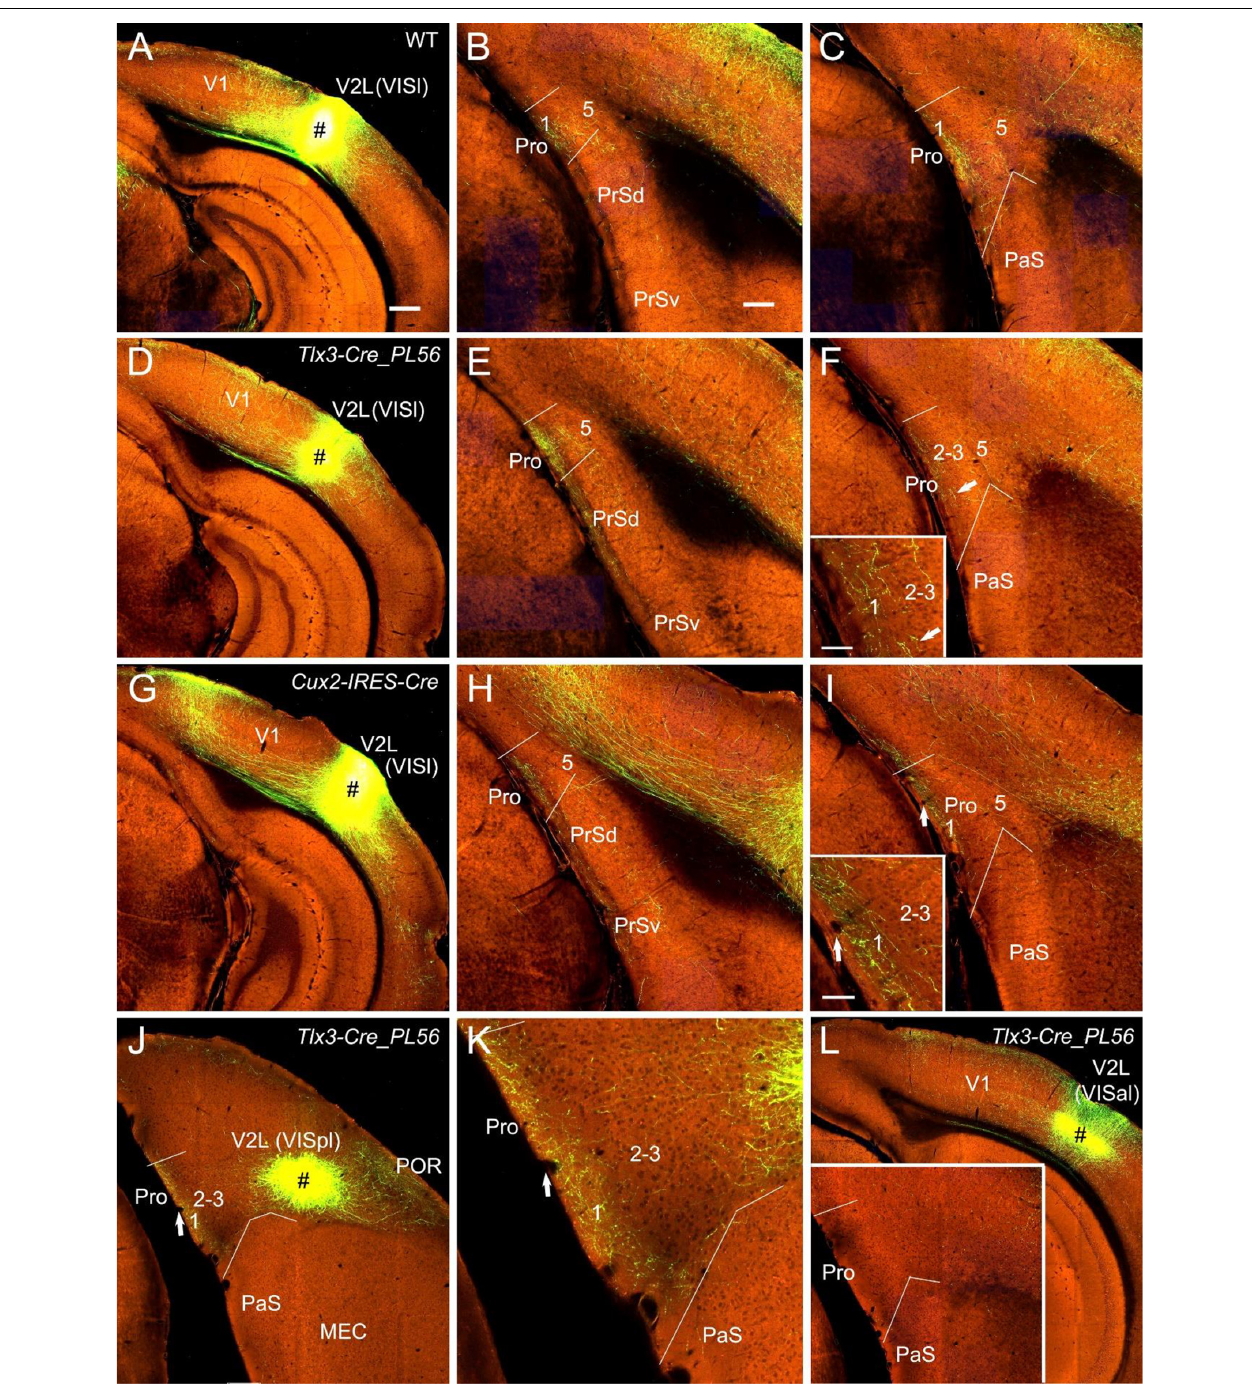
FIGURE 4 | Projections from lateral visual cortices to the Pro. (A–C) An injection in the V2L-VISl subfield (# in A ) of a WT mouse results in strong and weak terminal labeling in L1 and L2–3 of the Pro, respectively (B,C) . ( D–F) An injection in the V2L-VISl subfield (# in D ) of a Tlx3 -Cre_PL56 mouse (Cre expression in L5) leads to strong and weak terminal labeling in L1 and L2–3 of the Pro, respectively (E,F) . The Pro labeling in (F) is magnified in the inset. (G–I) An injection in the V2L-VISl subfield (# in G ) of a Cux2 -IRES-Cre mouse (Cre in L2–4) produces moderate terminal labeling in L1 of the Pro (H,I) . The Pro labeling in (I) is magnified in the inset. (J,K) An injection in V2L-VISpl subfield (# in K ) of a Tlx3 -Cre_PL56 mouse results in moderate terminal labeling in L1 of the Pro (K) . The Pro labeling in (J) is magnified in (K) . (L) An injection in the VISal subfield of V2 (#) of a Tlx3 -Cre_PL56 mouse does not result in terminal labeling in the Pro (see the inset). Arrows in low- and high-magnification images of the Pro point to corresponding locations. Bars: 350 µ m in (A) (for A , D , G , J , and K ); 200 µ m in (B) (for other panels and the inset in J ); 70 µ m in the inset in (F) and (I) .